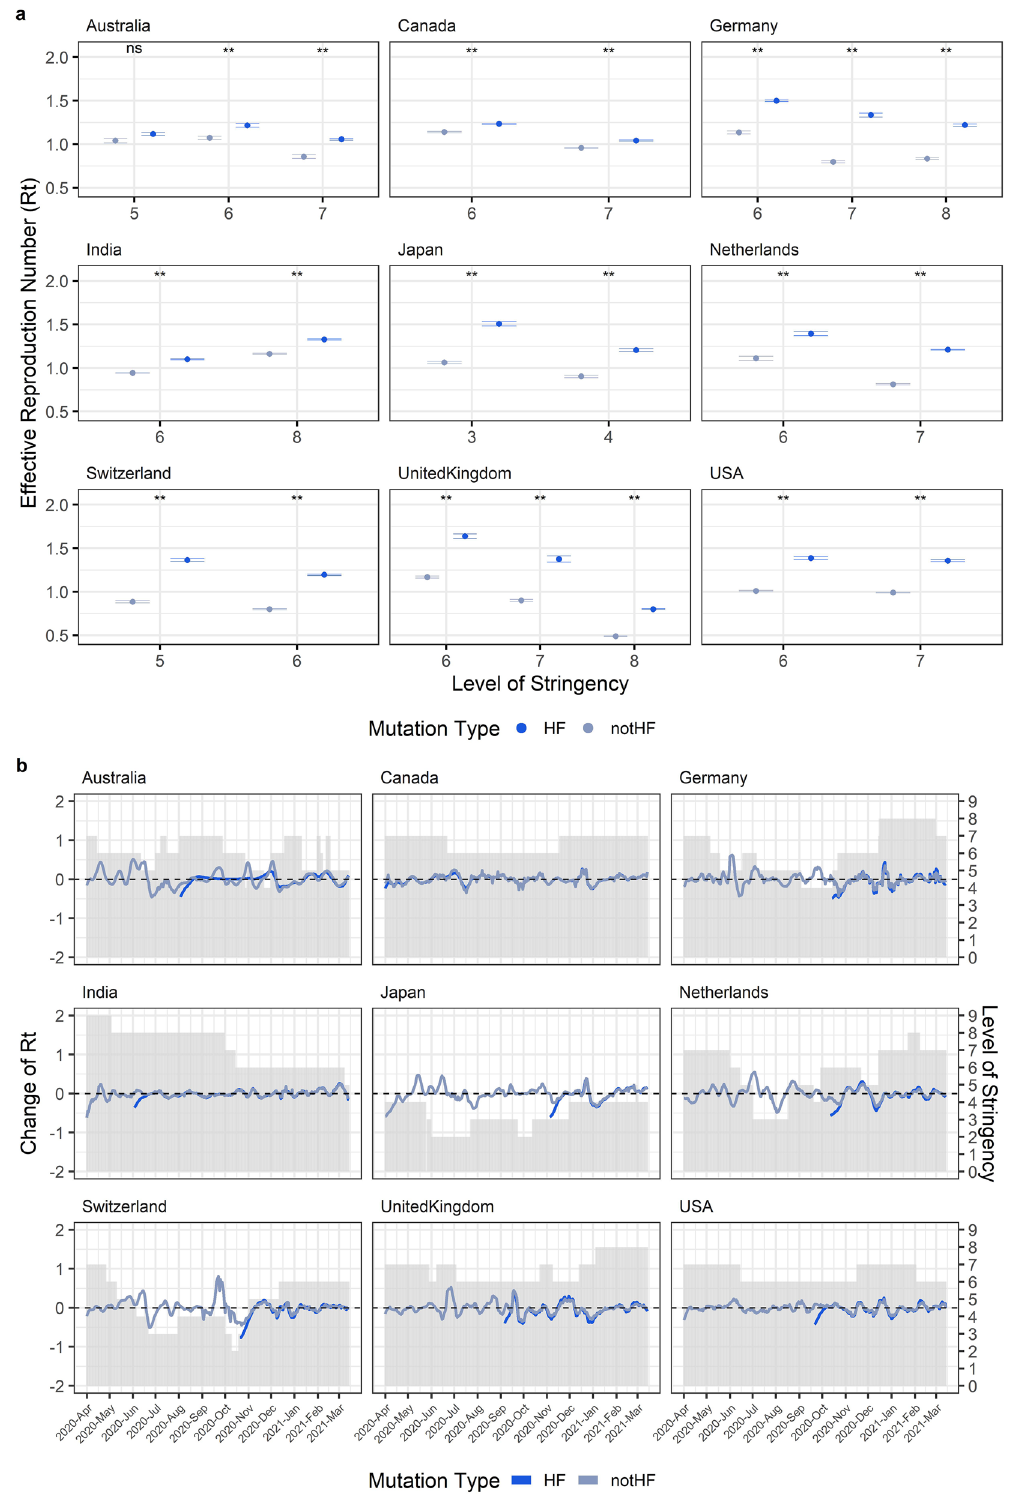
Figure 4. Effective reproduction number (Rt) of HF N501Y is higher than not-HF N501Y but similarly affected by the level of stringency. (a) Statistical comparison between the bootstrap distribution of the Rt of SARS-CoV-2 bearing (blue) or not (grey) the HF mutation N501Y (HF or notHF, respectively) in different levels of stringency. Points represent the mean and the lines represent the 25 and 75 percentiles of the bootstrap distribution. **Means p-value lesser than 0.05 and ns means p-value higher than 0.05. (b) Plot of the change of Rt in the time. Change of Rt was calculated as the Rt 14 days after the day of interest subtracted to the Rt mean between the day of interest and 13 days after that day. Grey bars are showing the level of stringency. Colors represent the same as in (a)